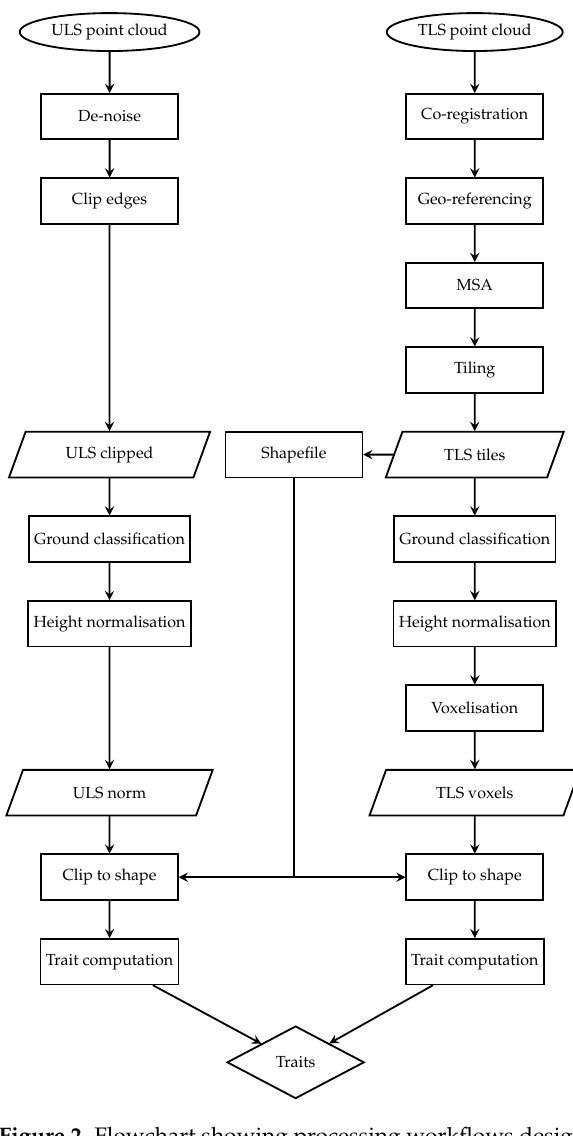
Figure 2. Flowchart showing processing workflows designed forTLS and ULS data interpretations into morphological functional traits.